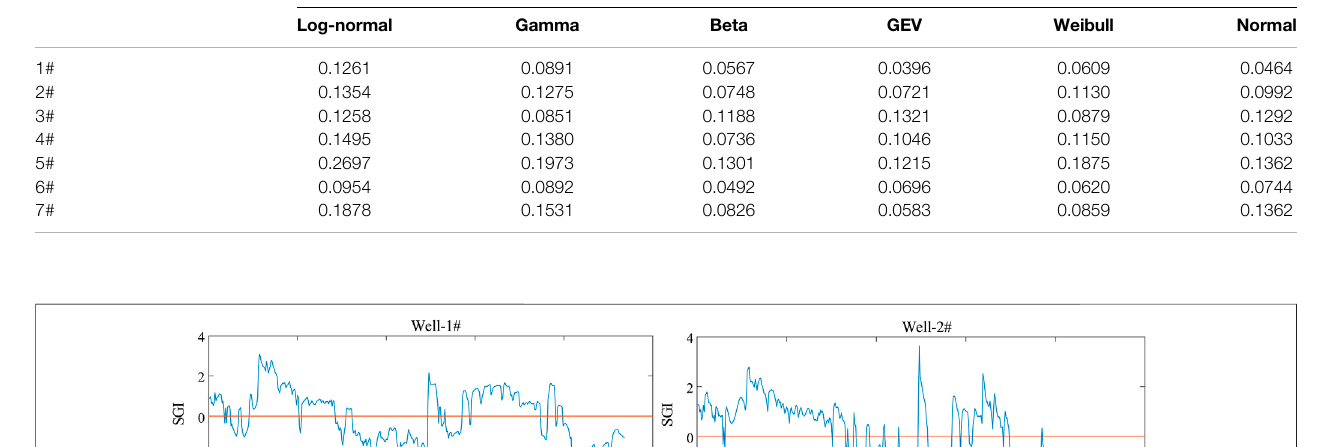
TABLE 1 | Results of the Kolmogorov – Smirnov test for seven wells. Observation well